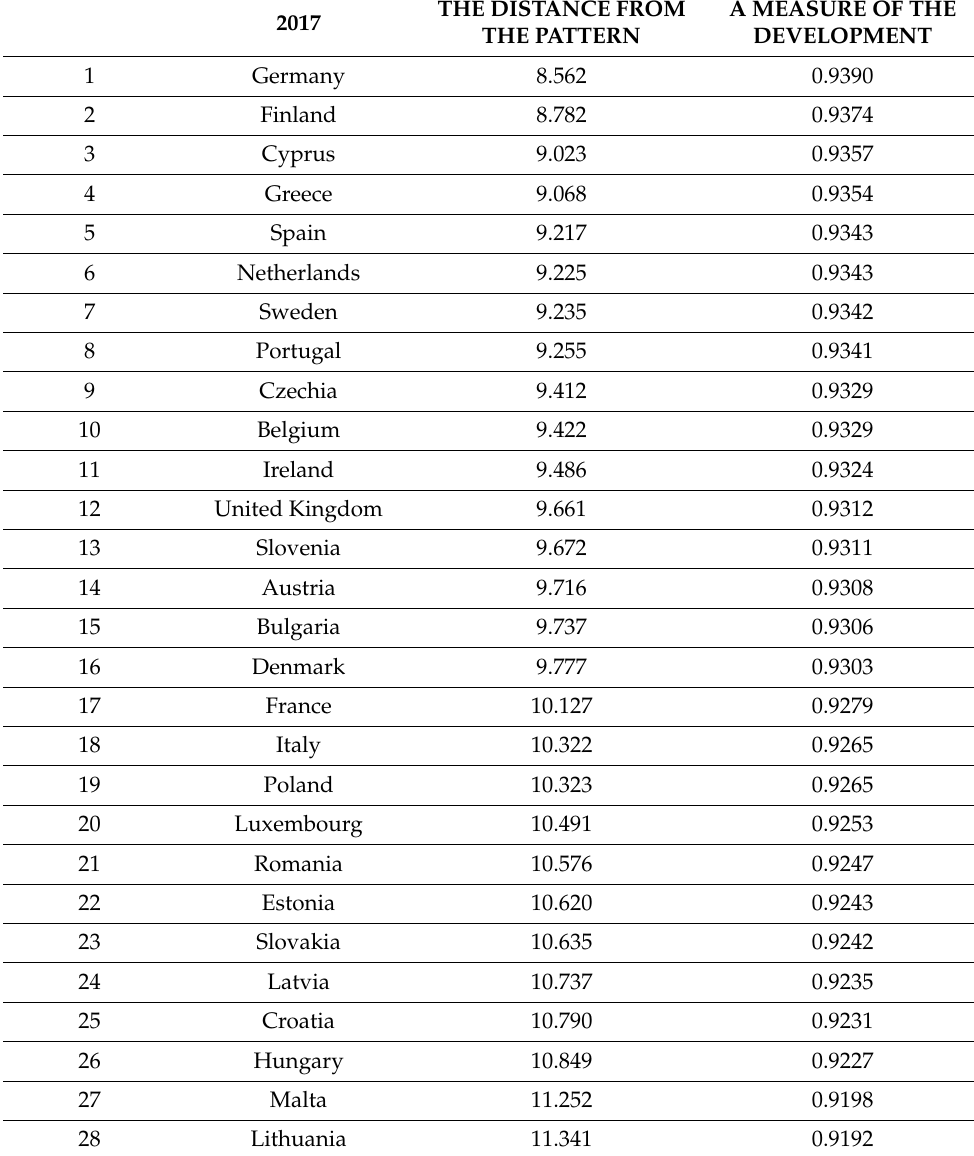
Table 2. The results of the linear order—the distance of objects from the development pattern and a measure of the development for energy production per capita in the European Union countries in